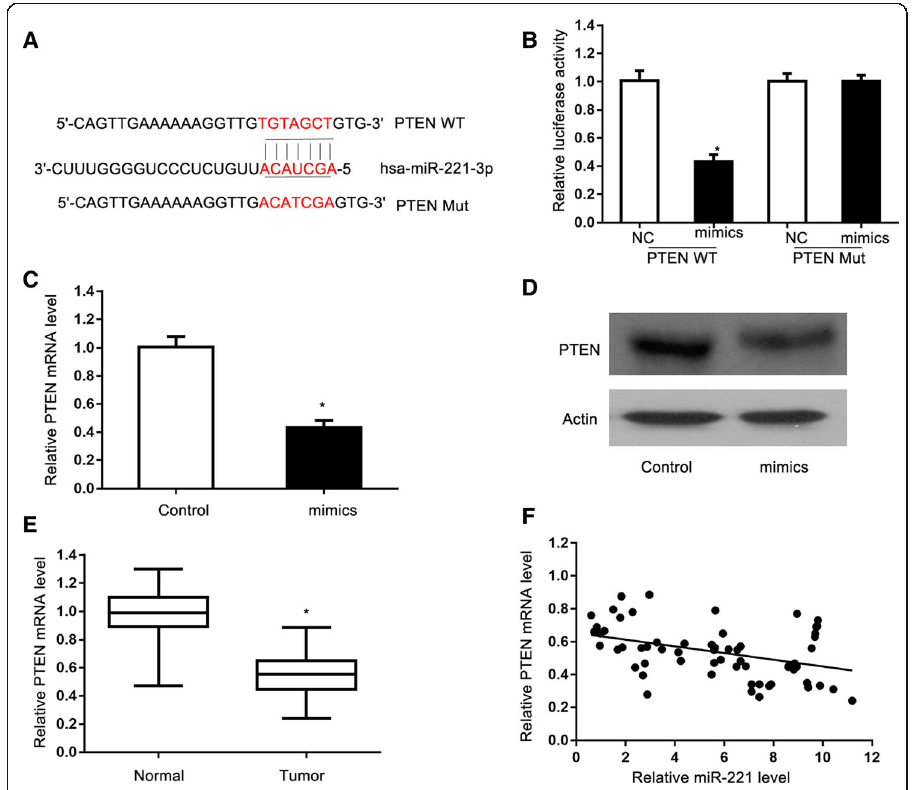
Fig. 4 PTEN is a direct target of miR-221. a Binding sequences for miR-221 in the 3 ′ -UTR of PTEN, and the mutations in the 3 ′ -UTR of PTEN are presented. b Luciferase activity of the wild type PTEN 3 ′ -UTR (Wt) and mutant T PTEN 3 ′ -UTR (Mut) co-transfected with miR-221 mimics or a negative control (miR-NC) was measured. c RT-qPCR analysis of PTEN mRNA in A431 and SCC13 cells following transfection with miR-221 inhibitor or mimics. d Western blotting was used to detect PTEN protein expression in A431 and SCC13 cells following transfection with miR-221 inhibitor or mimics. e Relative PTEN mRNA expression levels were determined using RT-qPCR in CSCC tissues and adjacent non-tumorous gastric mucosae tissues. f Analysis of correlation between miR-221 and PTEN mRNA expression in CSCC